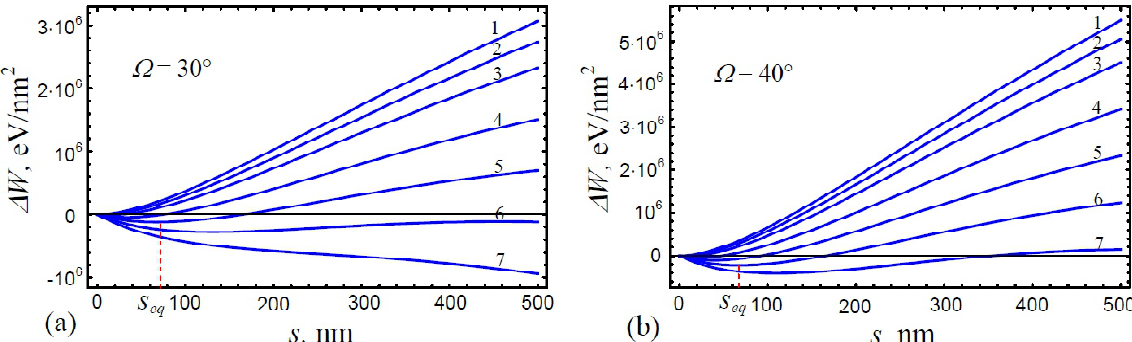
Fig. 2. Dependences the energy change  W on the migration distance s , for misorientation parameter W =30 ° (a) and 40 ° (b), at various values of the external shear stress  = 0.1,0.5,1,2,3,4, and 5 GPa (curves 1, 2, 3, 4, 5, 6, and 7,